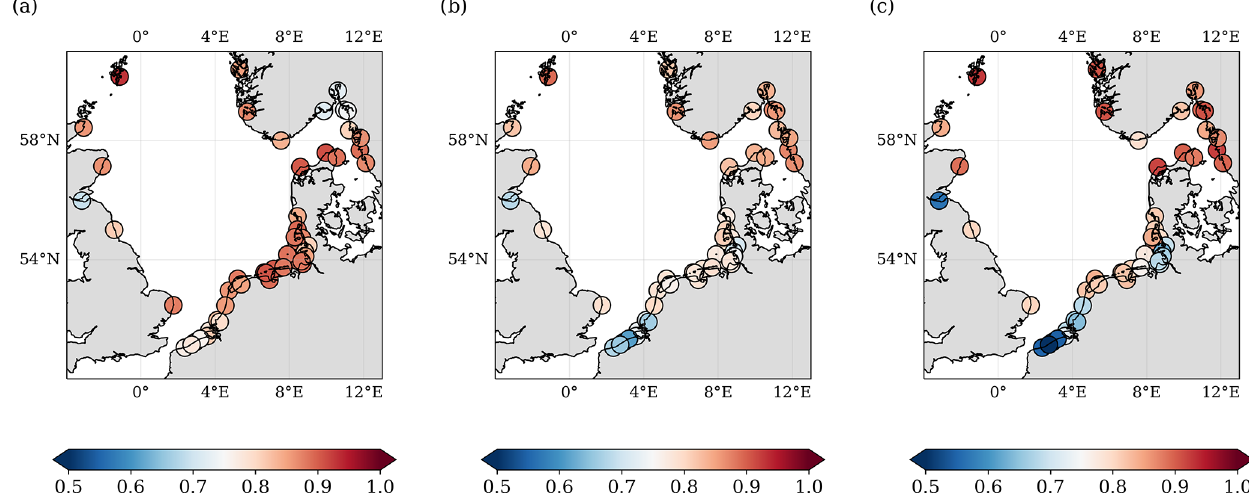
Figure 6. Correlations between altimetry sea level anomalies and measurements of 52 TGs computed over a period of 20 years (1995–2015) for three different altimetry datasets: (a) North SEAL, (b) CMEMS, and (c) SL_cci. The median correlations for all stations are 0.865 (North SEAL), 0.789 (CMEMS), and 0.816 (SL_cci). Quality flags of North SEAL grids have been